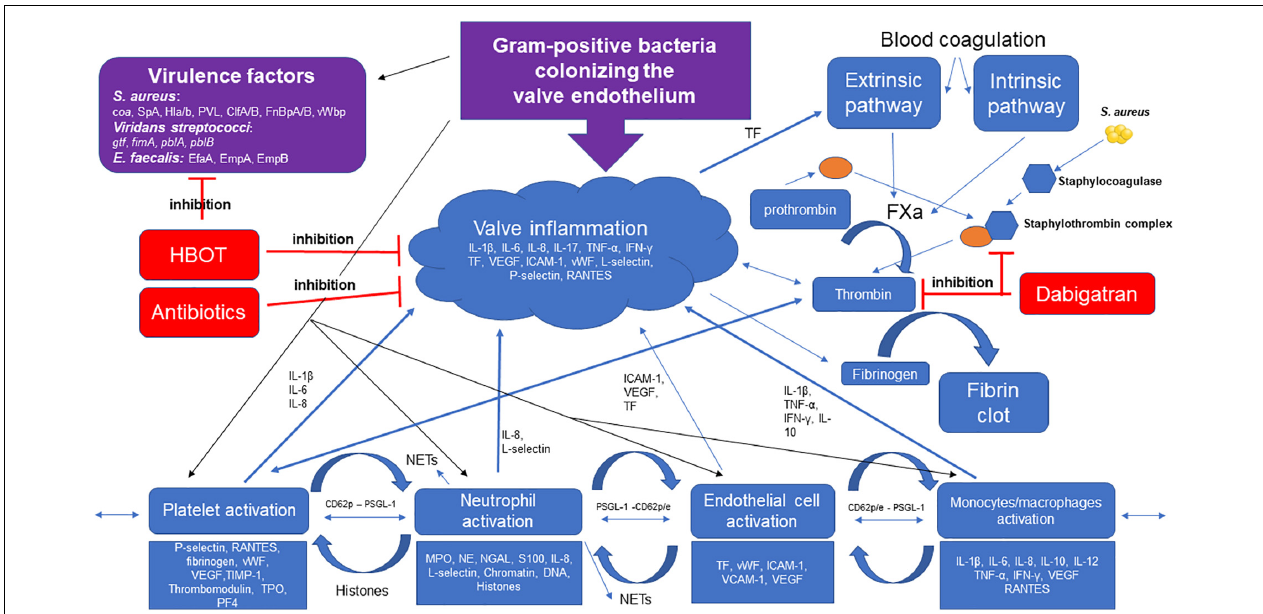
FIGURE 2 | Gram-positive bacteria colonizing the valve endothelium trigger multiple pathways of inflammation. S. aureus , viridans streptococci , and E. faecalis express important adhesion surface proteins/glucans, i.e., clumping factor A and B (ClfA/B), fibrinogen binding protein A and B (FnBpA/B), Coagulase ( coa ) von willebrand binding protein (vWbp), and glucosyltransferase ( gtf ), binding to the activated endothelial cell and extracellular matrix proteins in the vegetation. Host cells (platelets, neutrophils, and monocytes/macrophages) are recruited to the activated endothelium promoted by the pathogen’s increasing production of inflammatory markers. Tissue factor (TF) stimulates the extrinsic pathway increasing thrombin generation converting fibrinogen to fibrin inducing clot formation. Dabigatran is a direct thrombin inhibitor, limiting fibrin formation, HBOT potentiates the effect of antibiotics by decreasing inflammation and decreasing virulence of S. aureus . S. aureus and thrombin are potent activators of platelets, facilitating recruitment of neutrophil-binding to the surface of the vegetation, stimulating degranulation and neutrophil extracellular traps (NETs) formation, and further enhancing the clot and fibrin formation. The activated endothelial cells also stimulate